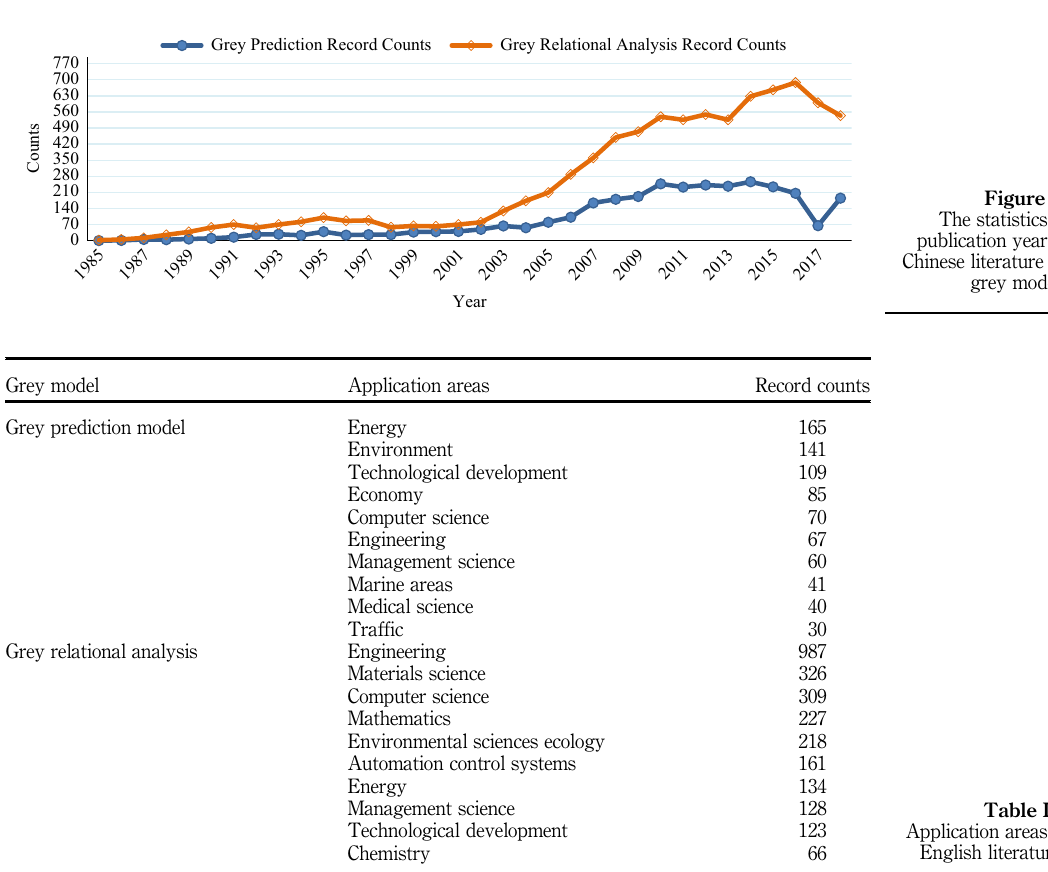
Table III. Application areas